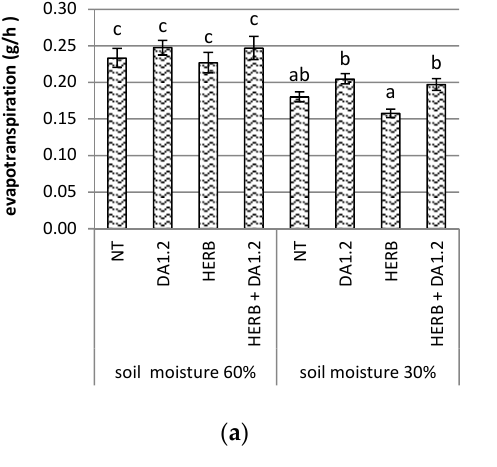
Figure 2. Indicators of wheat plants in pots on the 7th day after treatment: ( a ) evapotranspiration per one plant, n = 25; ( b ) the amount of malondialdehyde in leaves, n = 9. NT—no treatment was performed; DA1.2—bacterial treatment with Pseudomonas protegens DA1.2; HERB—herbicide treatment. Statistically different means are indicated by different letters ( p ≤ 0.05).